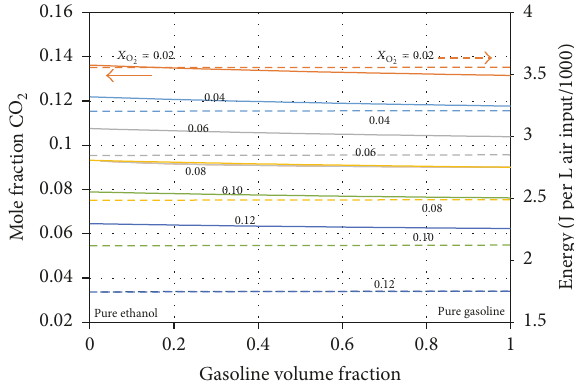
Figure 8: Using dry mole fractions of CO 2 and O 2 in the exhaust to estimate the gasoline volume fraction (solid lines) and energy released in J per L of air input (dashed line). Assume gasoline to be